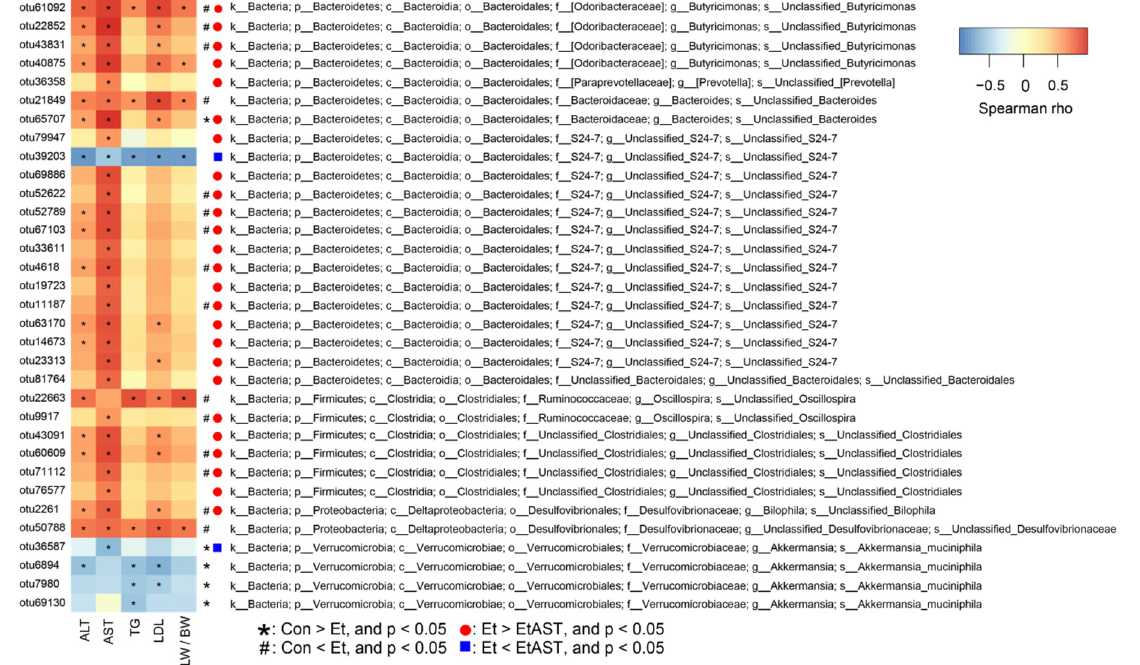
Figure 5. Heat map of 33 OTUs which were significantly associated with the AFLD disease phenotype altered by ethanol or astaxanthin as determined by Spearman’s correlation coefficient. These 33 OTUs were selected from the 43 OTUs which had significant changes after ethanol or astaxanthin treatment. The red and blue colors indicate the relative abundance of OTUs that were more or less abundant. The symbols * and # , shown on the right-hand side of the map, represent the OTUs whose abundances were reduced and increased in the Et group relative to those of the Con group, while the red circles and blue rectangles represent the OTUs whose abundances were reduced and increased in the EtAST group relative to the Et group. The symbol * in the cells of the heat map represents the significant correlation between the corresponding metabolic parameters and OTU abundance.